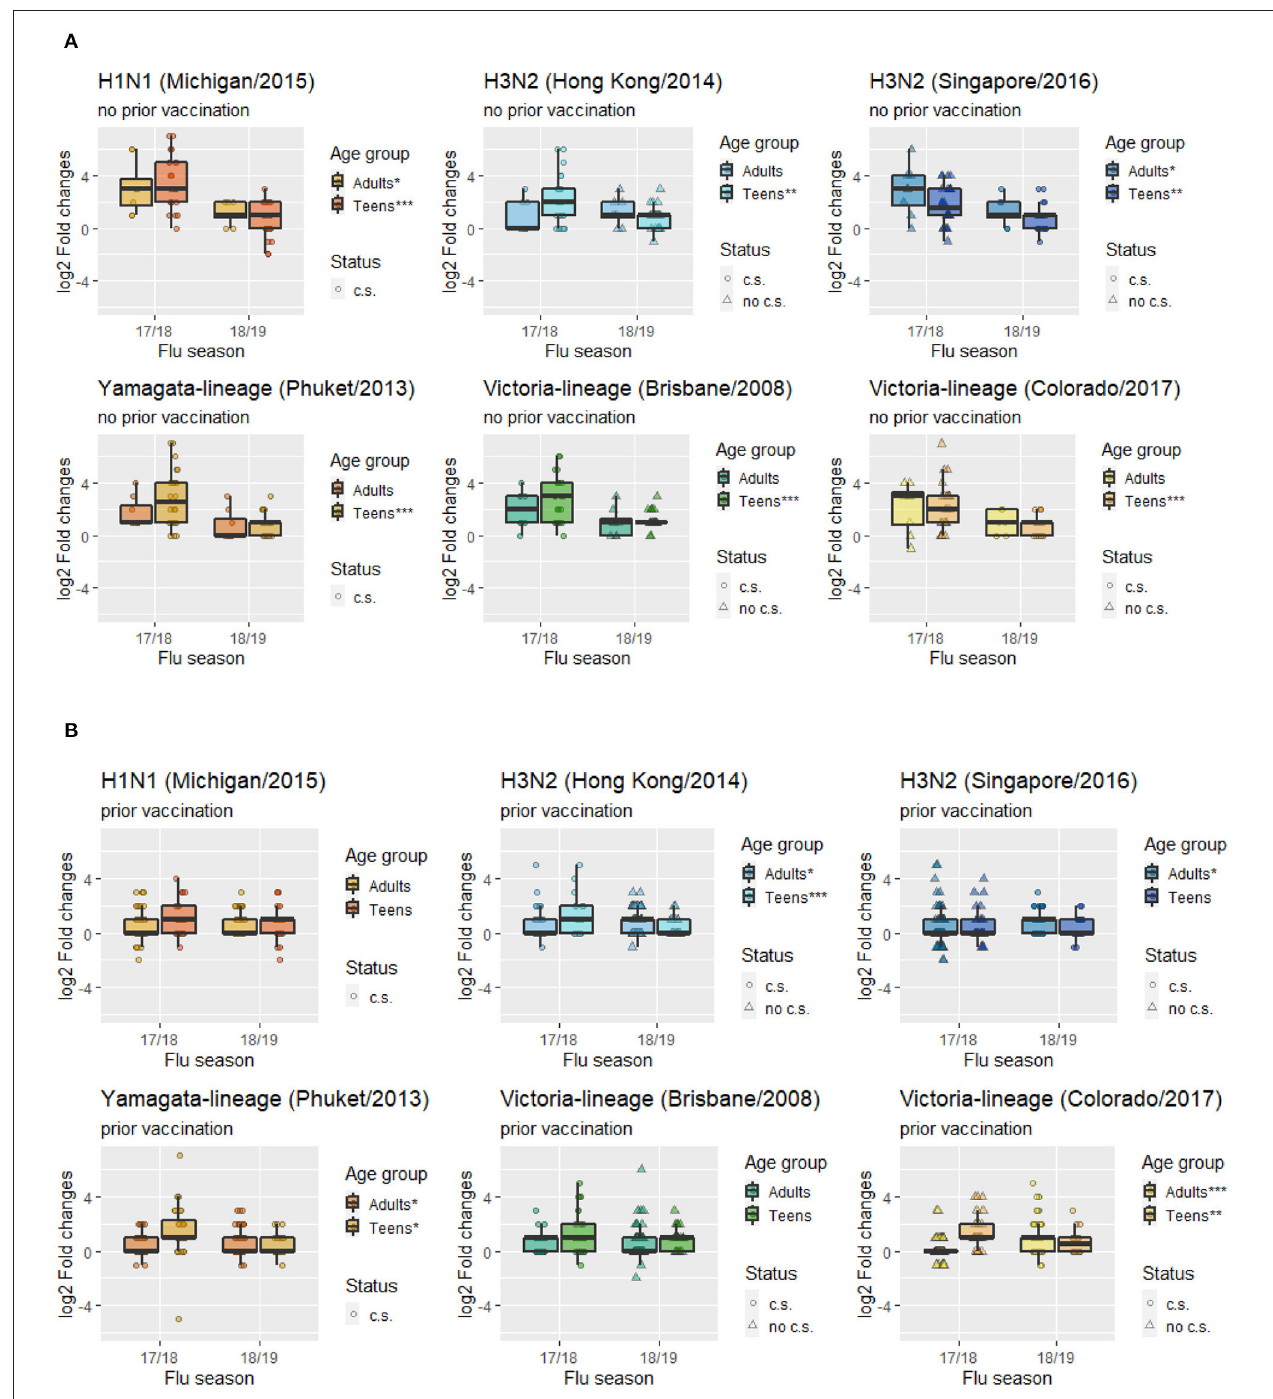
FIGURE 4 | Mean folds changes in HAI titers for each vaccine component strain stratified by age groups and prior vaccination status. (A) Subgroup with prior vaccination. (B) Subgroup with no prior vaccination. (c.s. in current season’s vaccine formulation; no c.s. not in current season’s vaccine formulation; *** p < 0.001, ** p < 0.01, * p <